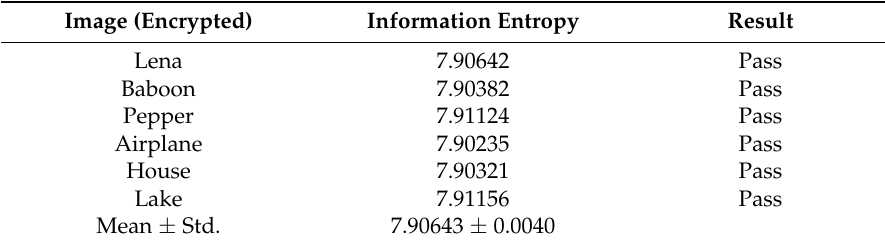
Table 7. Local information entropy of encrypted images ( k = 30, T B = 1936, α = 0.05). Image (Encrypted) Information